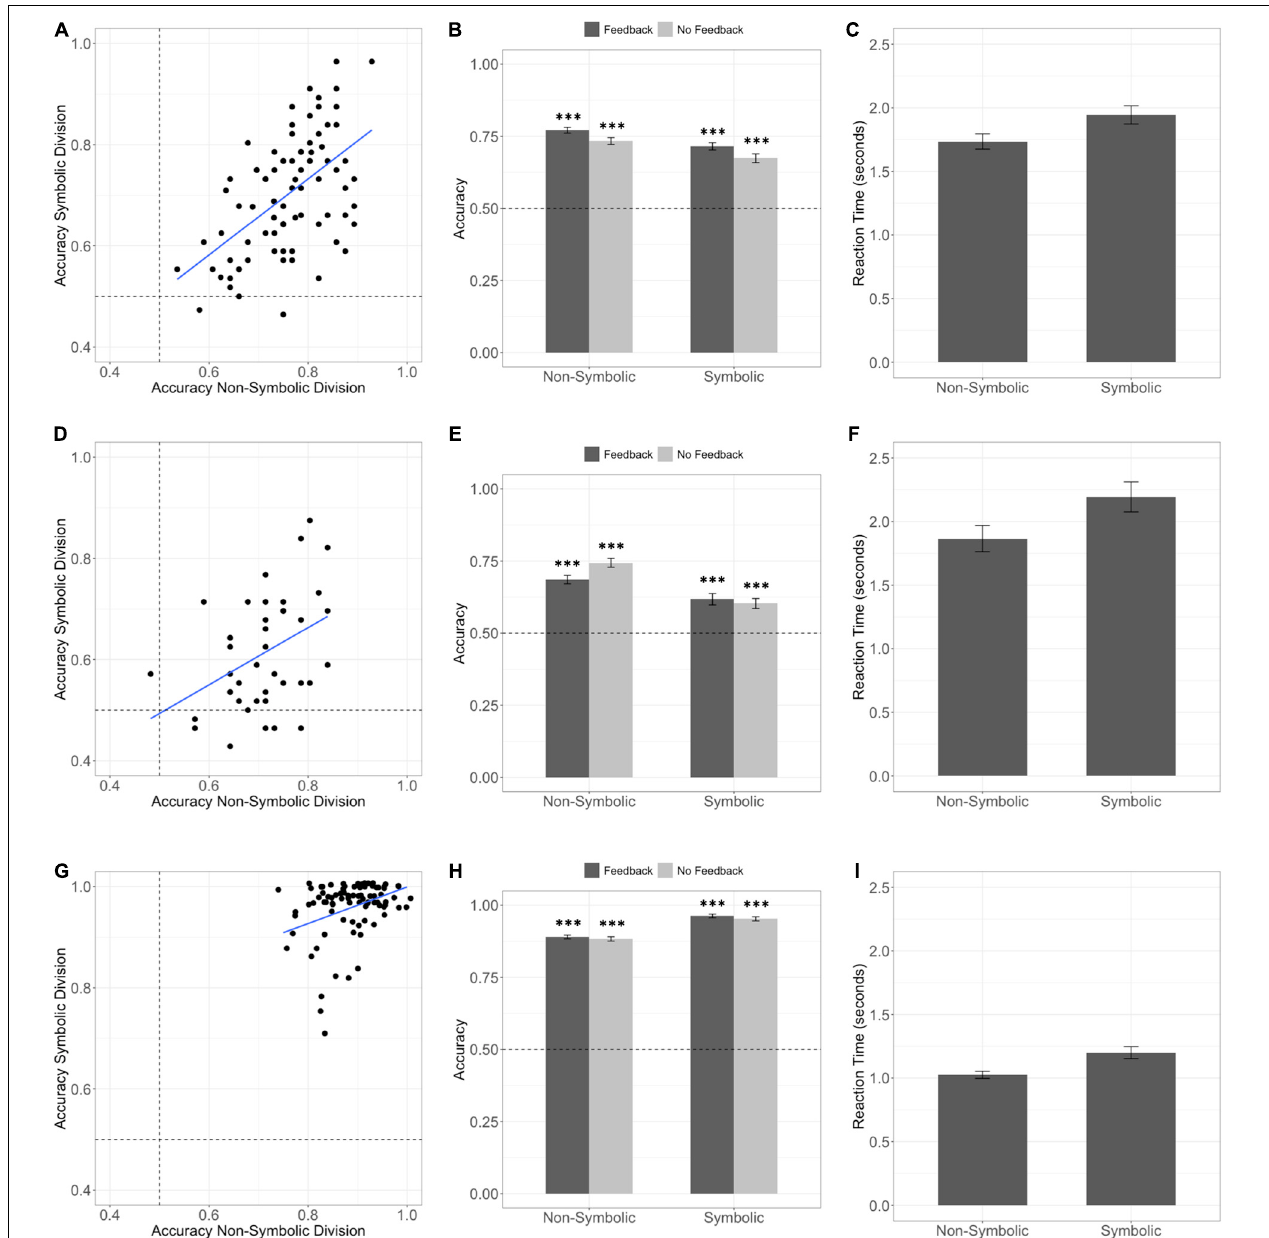
FIGURE 2 | Children and adults can successfully perform approximate division over non-symbolic and symbolic operands. The dotted line depicts chance performance. Error bars depict the standard error of the mean. ∗∗∗ p < 0.001 (A) Scatter plot depicting approximate non-symbolic and symbolic division overall accuracy in Experiment 1. (B) Children in Experiment 1 performed with above chance accuracy on both symbolic and non-symbolic division tasks on trials with feedback. Children also performed significantly above chance on both tasks during the no-feedback phase of the task where participants needed to divide with novel divisors. (C) Group level means of median reaction time on correct trials for the non-symbolic and symbolic tasks in Experiment 1. (D) Scatter plot depicting approximate non-symbolic and symbolic division overall accuracy in Experiment 2. (E) Children in Experiment 2 performed with above chance accuracy on both symbolic and non-symbolic division tasks on trials with feedback. Children also performed significantly above chance on both tasks during the no-feedback phase of the task where participants needed to divide with novel divisors. (F) Group level means of median reaction time on correct trials for the non-symbolic and symbolic tasks in Experiment 2. (G) Scatter plot depicting approximate non-symbolic and symbolic division overall accuracy in Experiment 3 with adult subjects. Points are jittered horizontally to reveal overlapping data points. (H) Adults in Experiment 3 performed with above chance accuracy on both symbolic and non-symbolic division tasks on trials with feedback and trials without feedback with novel divisors. (I) Group level means of median reaction time on correct trials for the non-symbolic and symbolic tasks in Experiment 3.